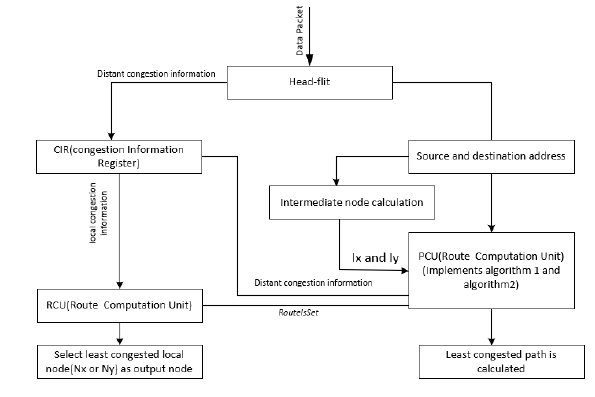
Fig. 7. Flow graph for implementing the proposed routing